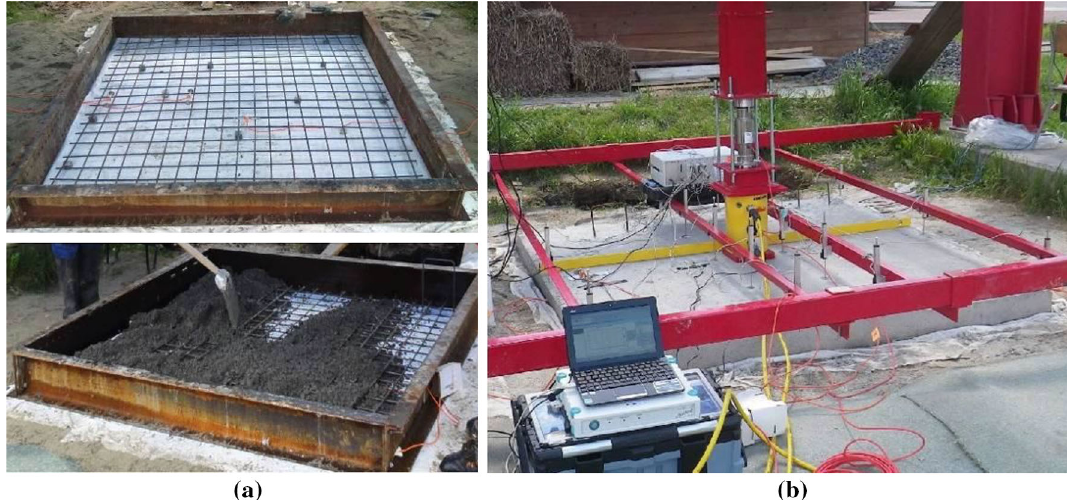
Fig. 3 Concreting of the slab model and loading test. a Concreting of the slab and b Loading test measured at 16 points. The sensor positions are shown in Fig. 3. The hydraulic press and sensor set were synchronized using Ahlborn measuring device. Tensometric measurements were also taken at selected points of the concrete slab to verify the slab behaviour.